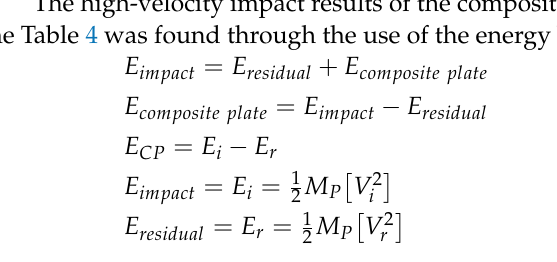
Table 4. Energy absorption of composite